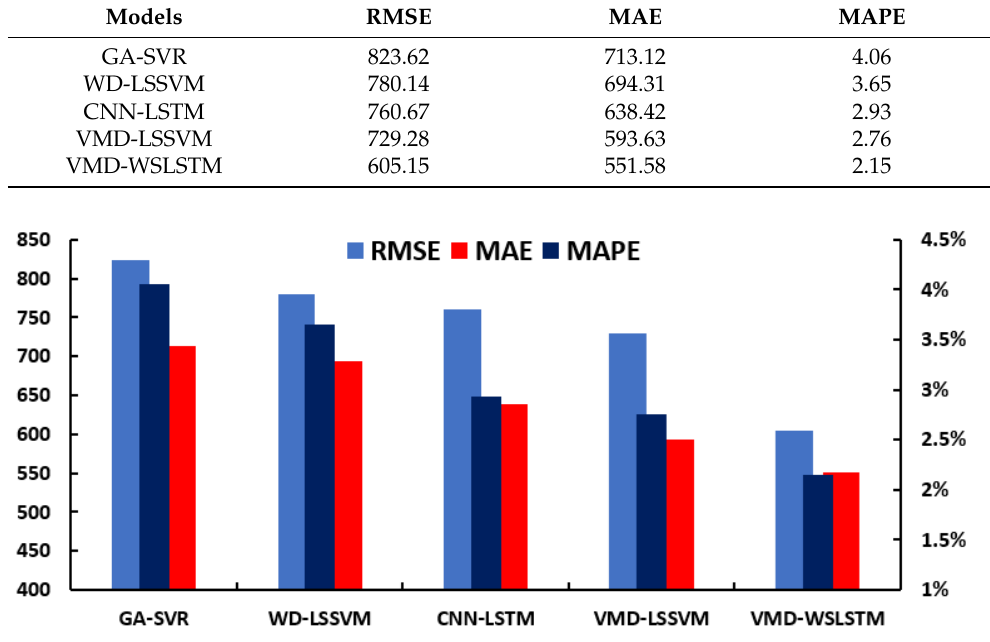
Figure 10. Prediction results of different models.